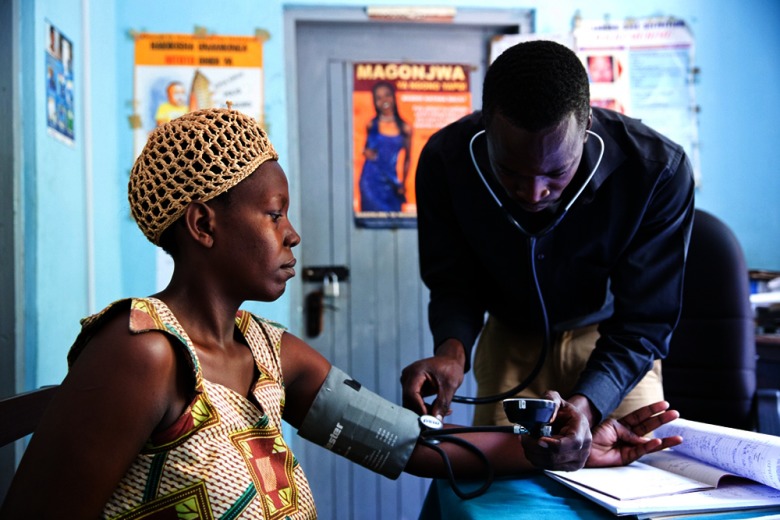
A clinical officer screens a woman for tubal ligation in a health facility in northern Tanzania. © 2014 EngenderHealth/S. Lewis